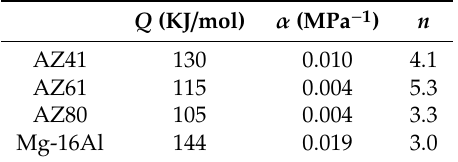
Table 1. The Q , α , and n values of various extruded AZ Mg